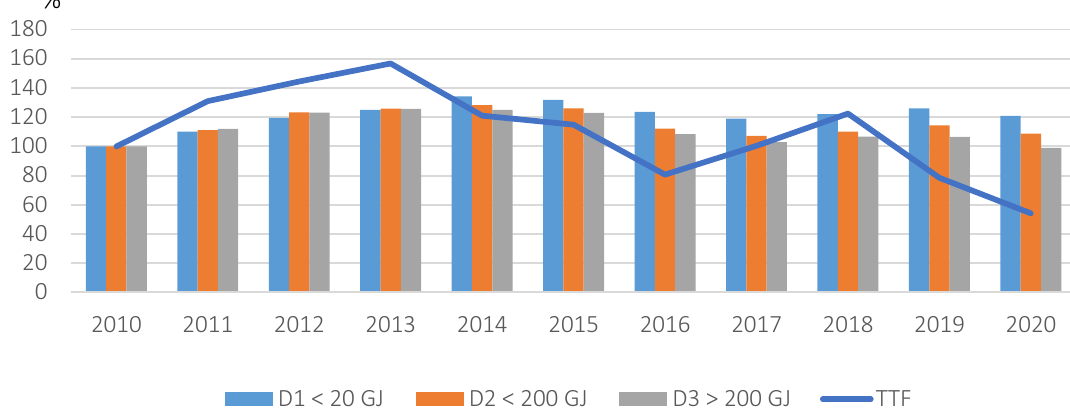
Figure 1. Change in the tariff for natural gas by category of households, excluding taxation in the EER